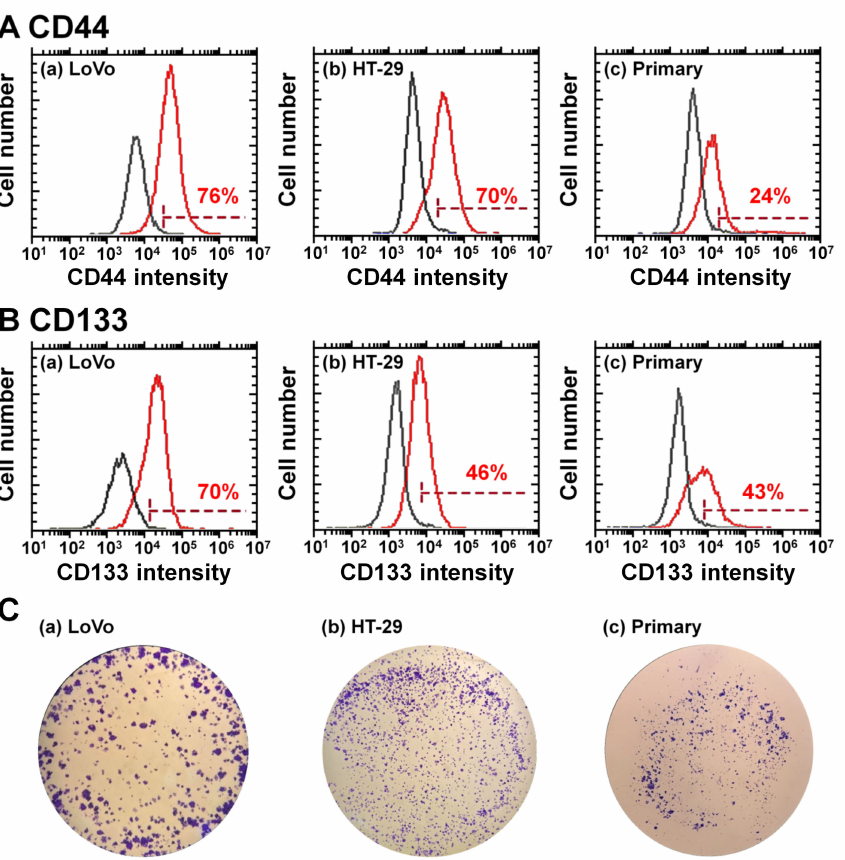
Figure 6. Characterization of primary colon carcinoma (M-24) cells derived from patient colon tumor tissues. ( A ) Flow cytometry chart of CD44 expression on LoVo cells ( a ), HT-29 cells ( b ), and primary colon carcinoma cells derived from patient colon tumor tissues ( c ). ( B ) Flow cytometry chart of CD133 expression on LoVo cells ( a ), HT-29 cells ( b ), and primary colon carcinoma cells ( c ). ( C ) Colony-forming photos of colon carcinoma LoVo cells ( a ), HT-29 cells ( b ), and primary colon carcinoma (M-24) cells derived from patient colon tumor tissues ( c